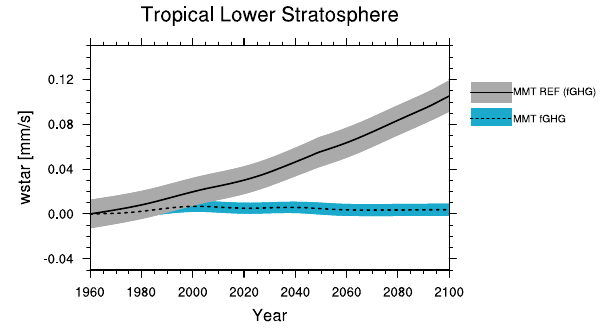
Fig. 5. Multi-model mean and 95% confidence interval of the 1960 baseline-adjusted annual mean w* between 20 ◦ S and 20 ◦ N at 70hPa for REF-B2 (solid black line and grey shaded area) and fGHG (black dashed line and blue shaded area). The individual models are shown in the supplementary material in Fig.